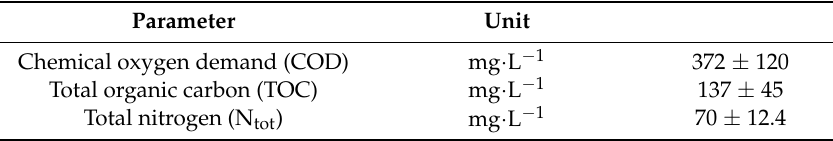
Table 1. Average characteristics of the raw domestic sewage used as influent in the filtration experiment. E. coli and enterococci concentration are given as most probable number (MPN). Variation ranges indicate the standard deviations ( n = 6).